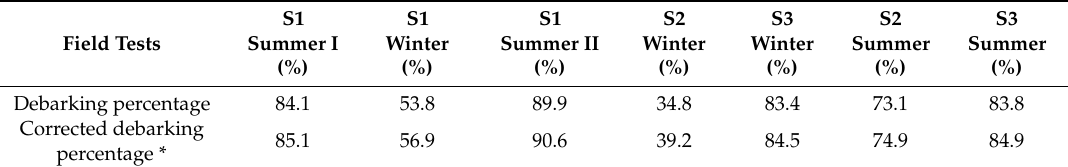
Table 5. Measured average debarking percentages of the field application of the system corrected based on findings of the laboratory accuracy